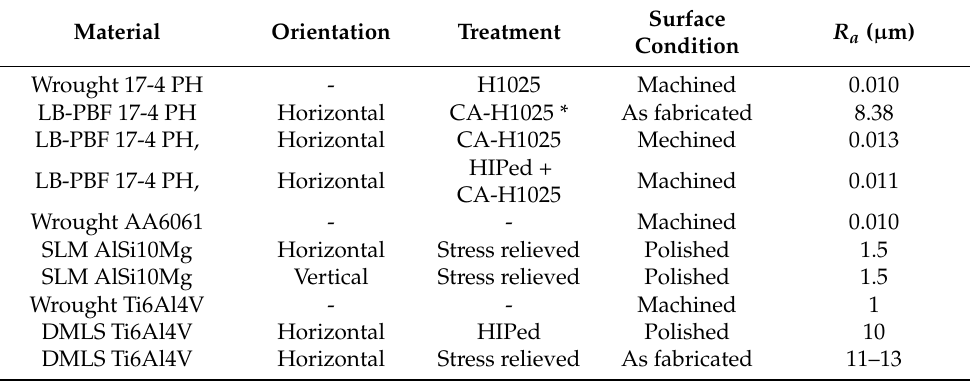
Table 1. Material conditions and surface roughness (data taken from [13,14].